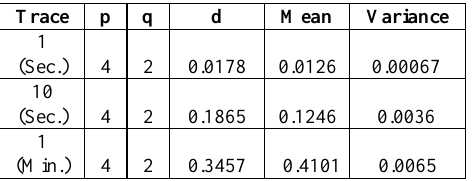
Table 1. FARIMA Model Parameters